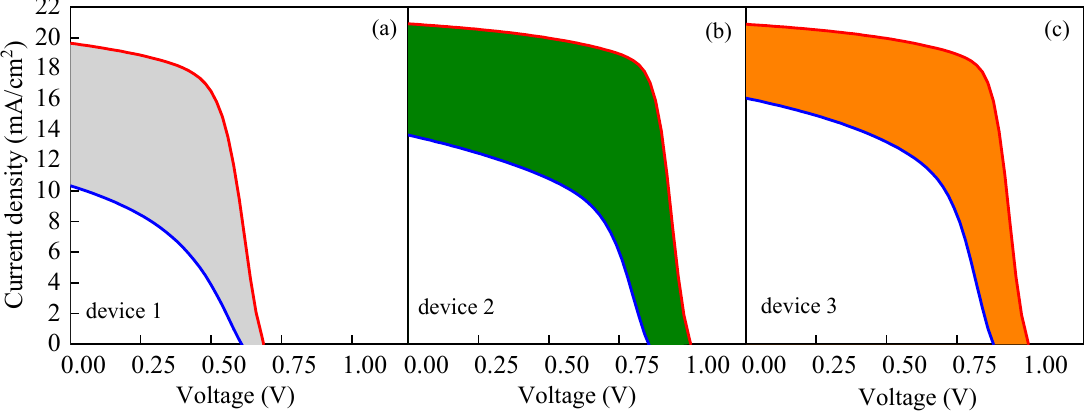
Figure 14. Change of J-V characteristic curve when N t is 10 13 and 10 17 cm − 3 : ( a ) change in J-V characteristic curve of device 1, ( b ) change in J-V characteristic curve of device 2, and ( c ) change in J-V characteristic curve of device 3.